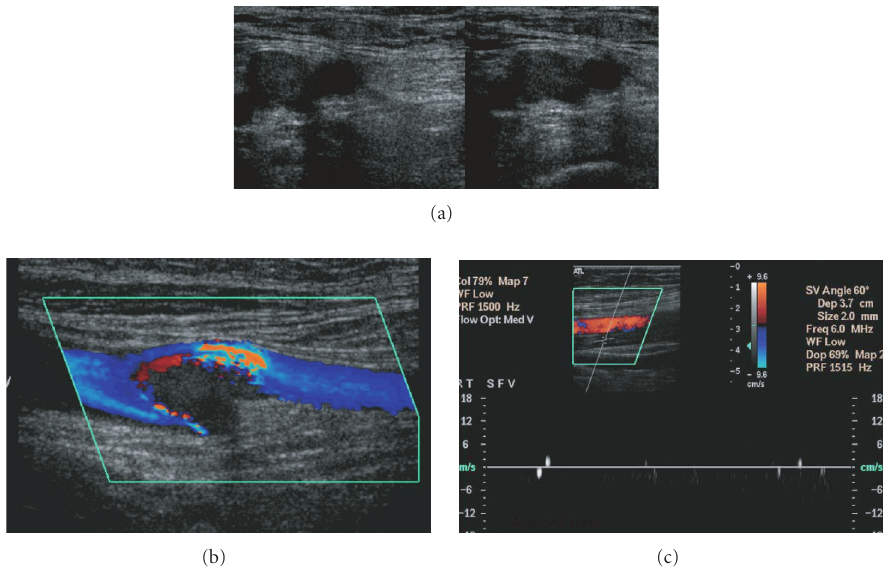
Figure 3: Thrombotic vein. (a) Echogenic lumen, enlarged, noncompressible vein. Left side: before compression; right side: during pressure exerted by the probe, the vein does not collapse. (b) Thrombus at the bifurcation of the femoral vein, seen as color void and turbulent surrounding flow. (c) No flow demonstrated on duplex in a thrombotic femoral